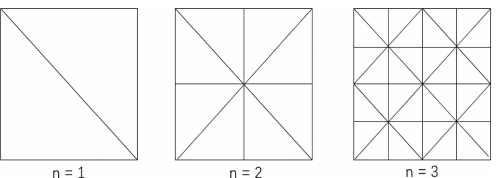
Figure 7. Equally divided grid used to perform the spatial sampling of the amplitude